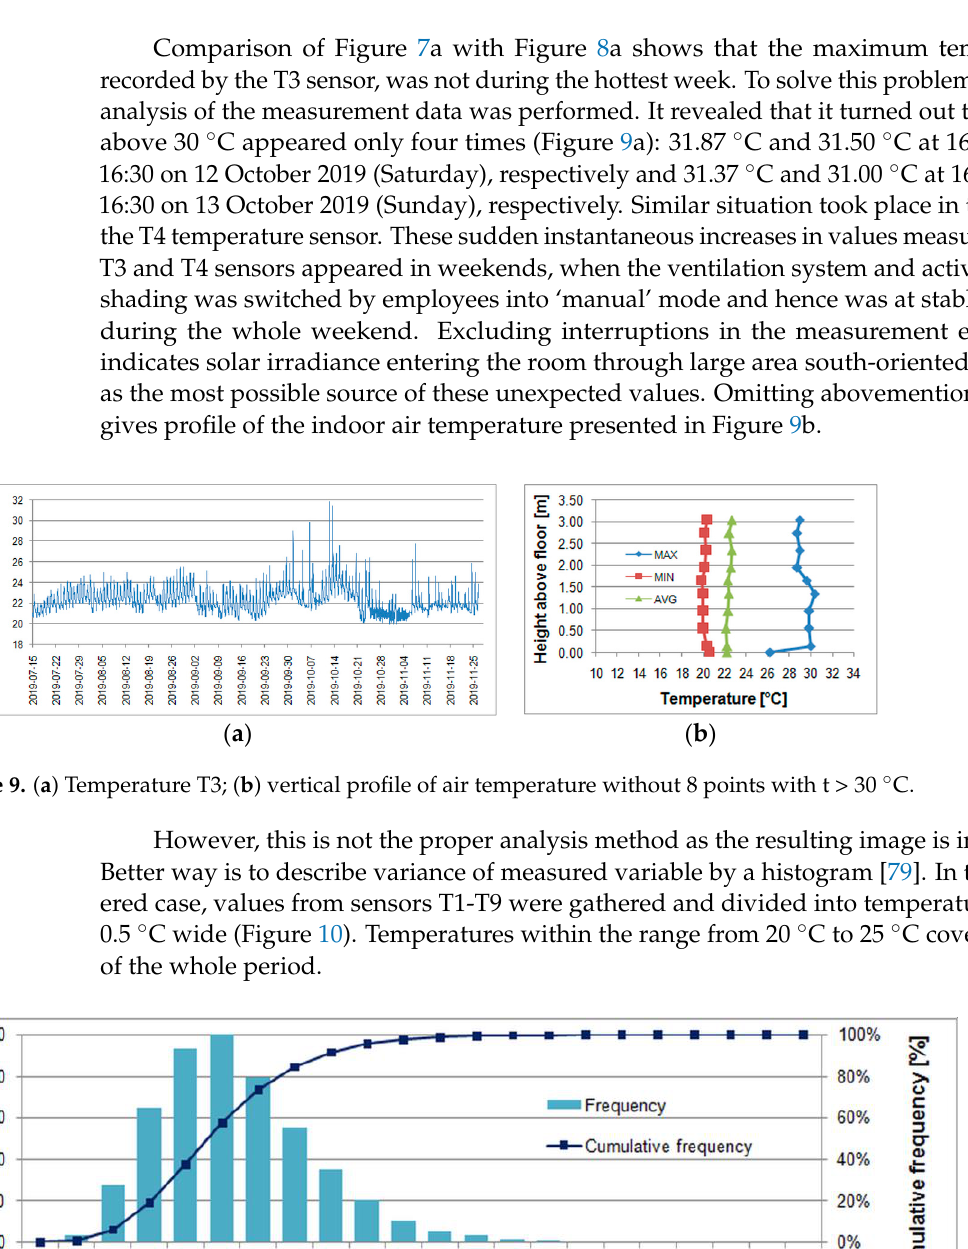
Figure 10. Internal air temperaure distribution during the whole measurement period.